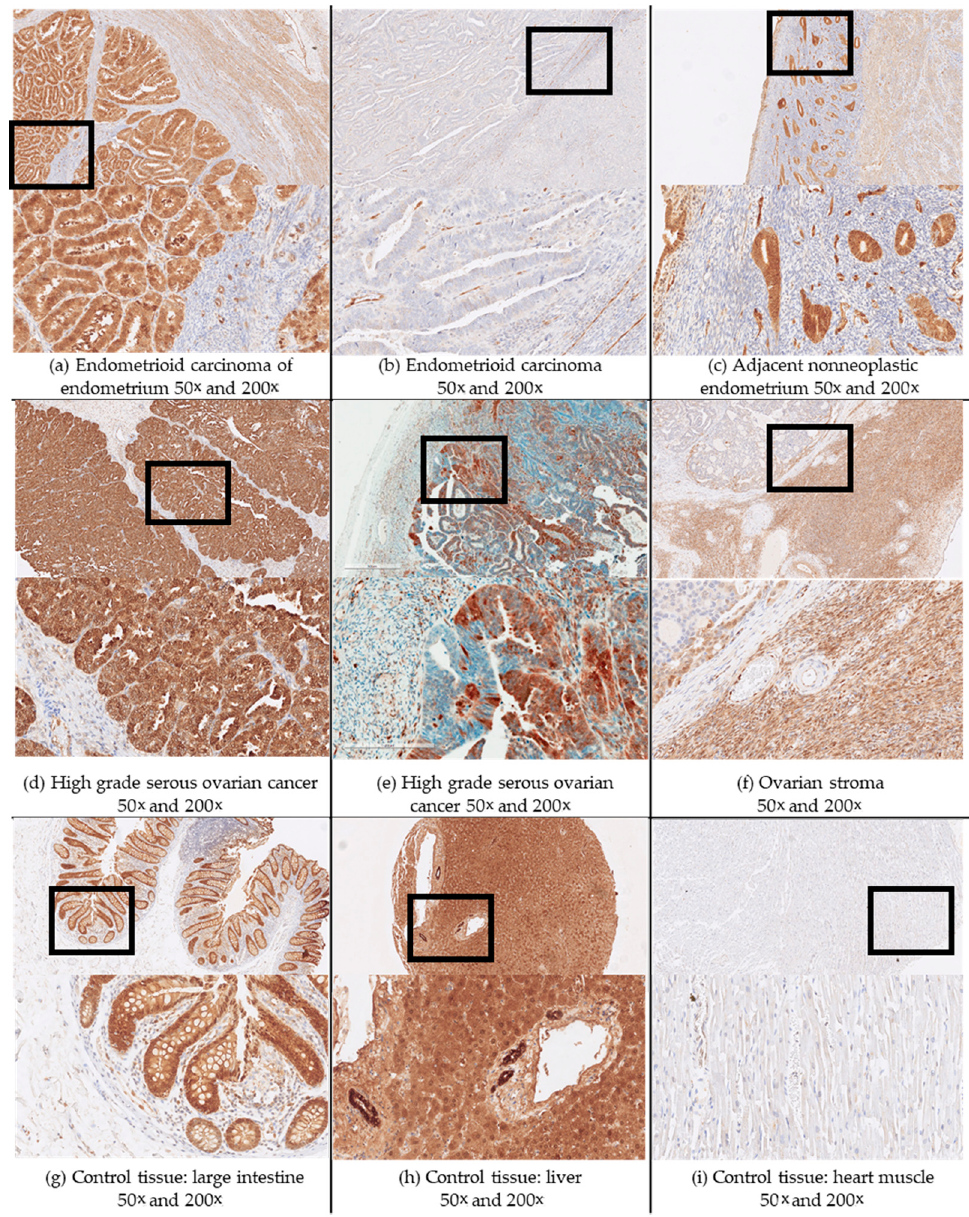
Figure 1. Representative immunohistochemistry staining for AKR1C3 in samples of endometrial and ovarian cancers, and in control tissue. Upper half of panels, 50 × magnification. Black box fields, area shown below at 200 × magnification.